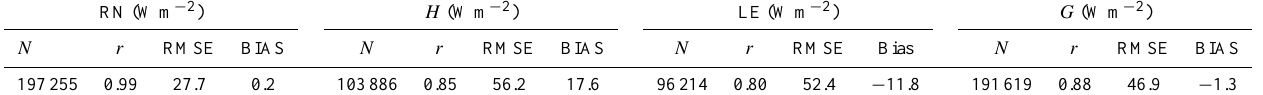
Table 5. Performances of the simulated energy fluxes for the standard simulation PTF. RN is the net radiation. H , LE and G are the sensible, latent and ground heat fluxes. The metrics were computed over the valid measurements available for each variable. For LE, only the 2004– 2012 period is used. N and r are the number of samples and the correlation coefficient, respectively.